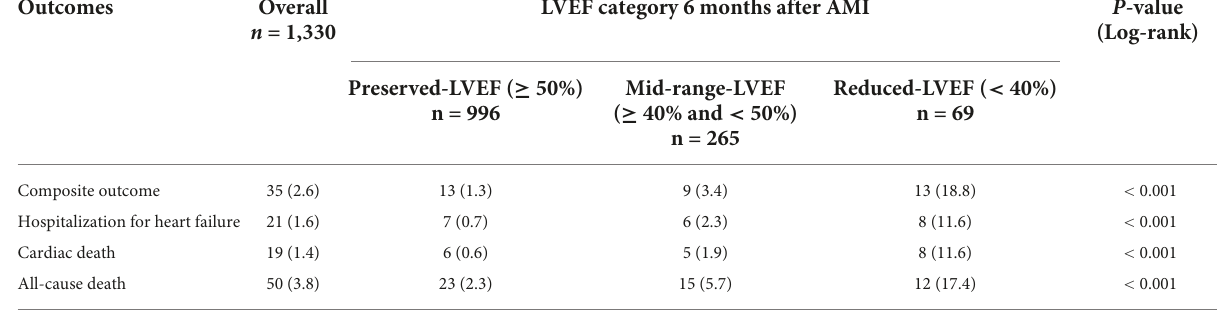
TABLE 4 Clinical